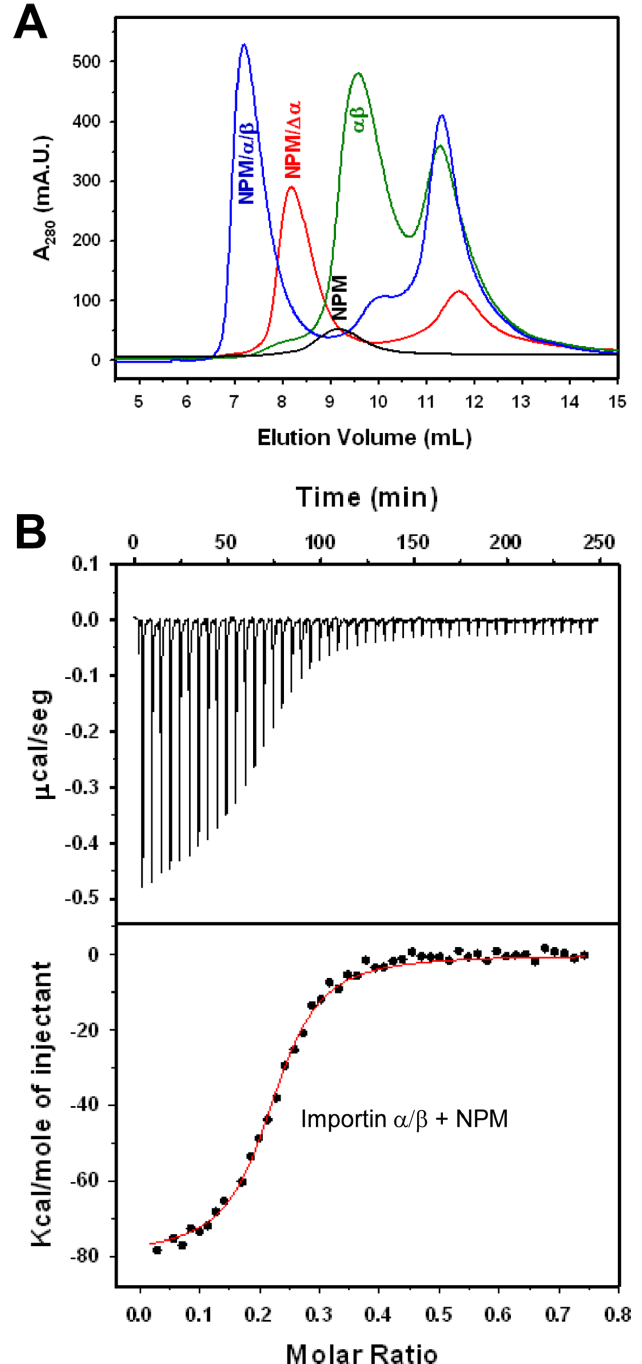
Fig 6. Analysis of importin α / β /NPM interaction by SEC and ITC. (A) Elution profiles of mixtures of 10 μ M (pentamer) NPM with 70 μ M importin Δα (red) or 70 μ M importin α and 140 μ M importin β (blue), and mixture of 70 μ M importin α and 140 μ M importin β (green). The control of 10 μ M NPM (black) is also shown. The complexes are saturated, as evidenced by the absence of free NPM, and excess of free importins. Importin β was always added in molar excess to avoid the presence of free importin α , which also binds NPM, although with lower affinity. (B) Titration of importin α / β (21 μ M) onto NPM (7.2 μ M pentamer) (top panel) and fit of the binding isotherm by an independent binding sites model (bottom panel), with a χ 2 / DoF of 3.22 x 10 6 .